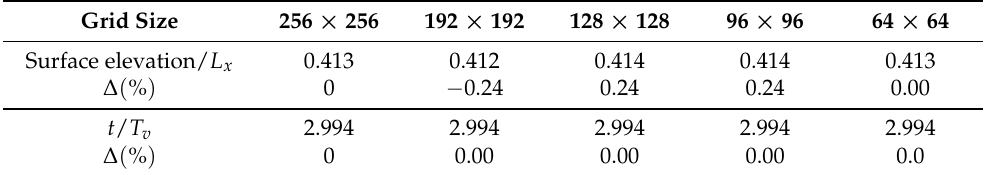
Table A10. Spacial grid sensibility analysis for the nonlinear regime: maximum value of surface